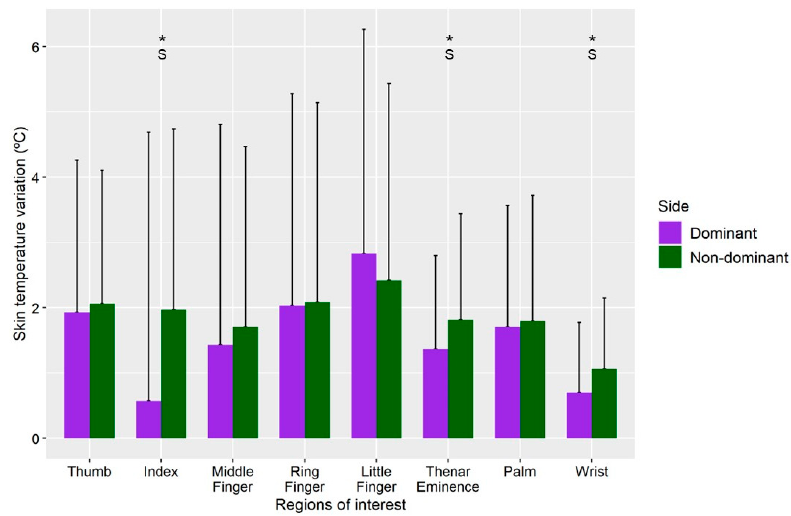
Figure 4. Mean and standard deviation of skin temperature variation in the dominant and non- dominant hand by ROIs in the athletes group. Differences were analyzed between the dominant and non-dominant hand (* p < 0.05). S = Small Effect Size.